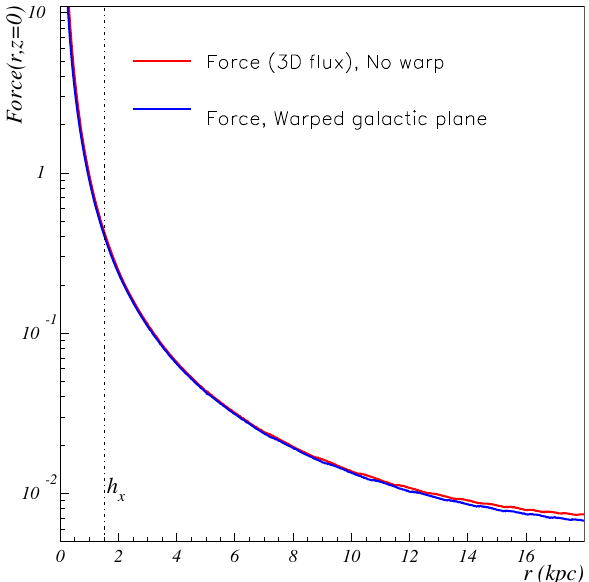
Fig. 9 In-plane ( z = 0) flux (viz force in arbitrary unit) in function of radius r for a flat (red curve) and warped disk (blue curve). The curves are calculated with the galactic parameters given in Fig. 4. The radial characteristic scale h r = 1 . 5 kpc is indicated by the vertical dot-dashed